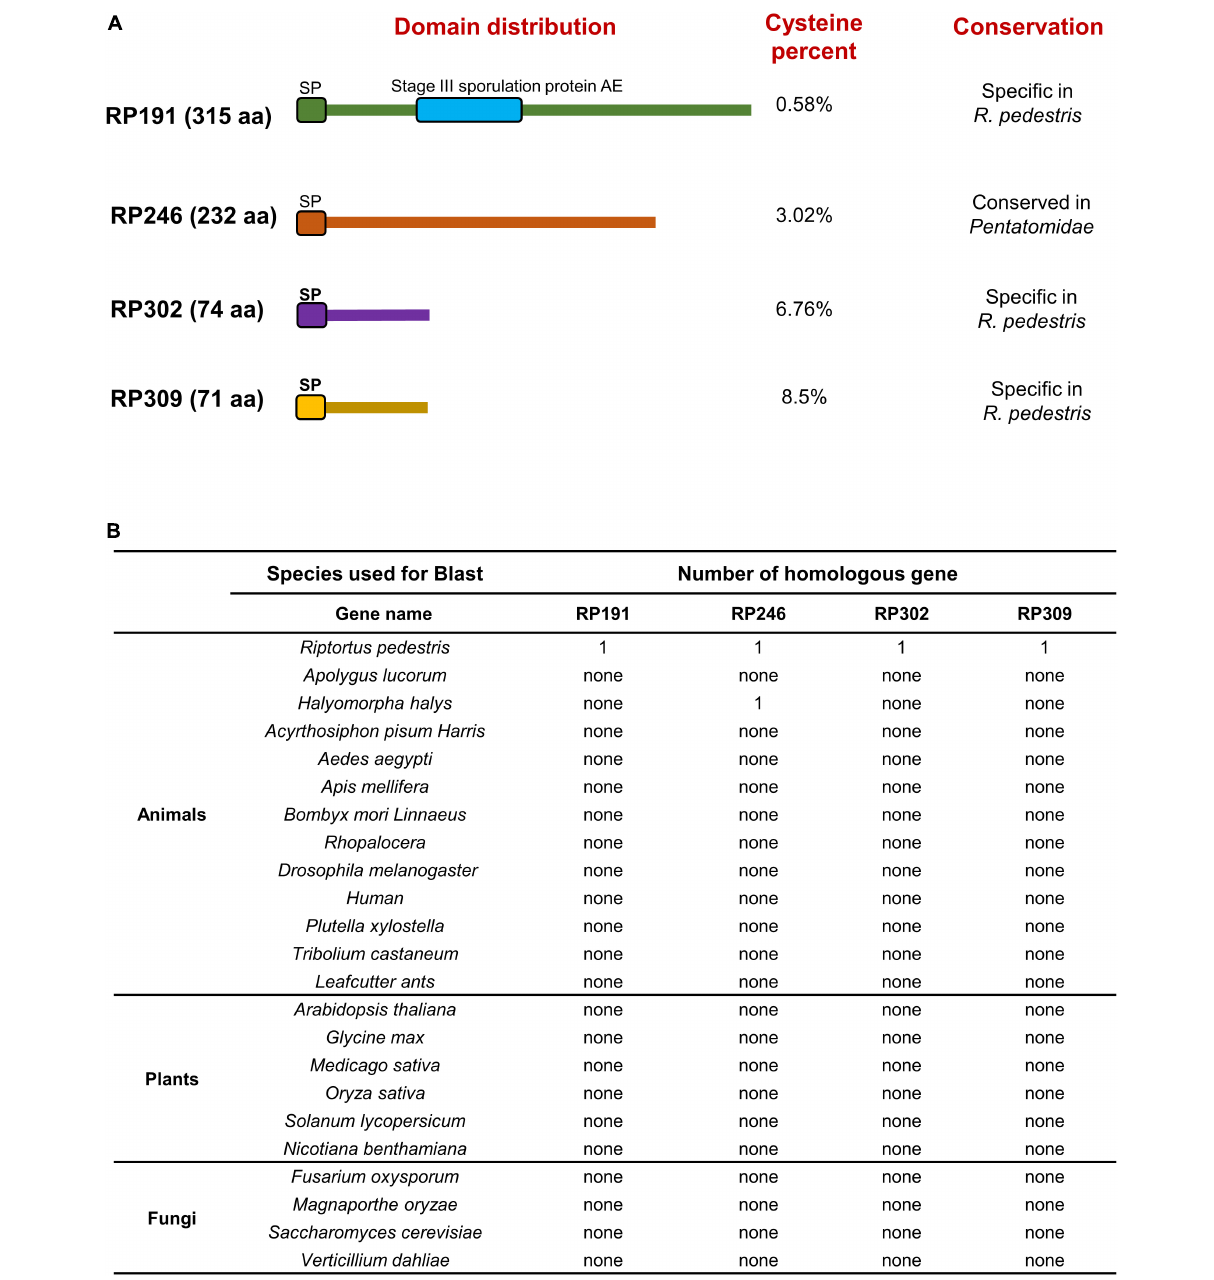
(CRNs) and RxLR (Wang and Wang, 2018; Huang G.